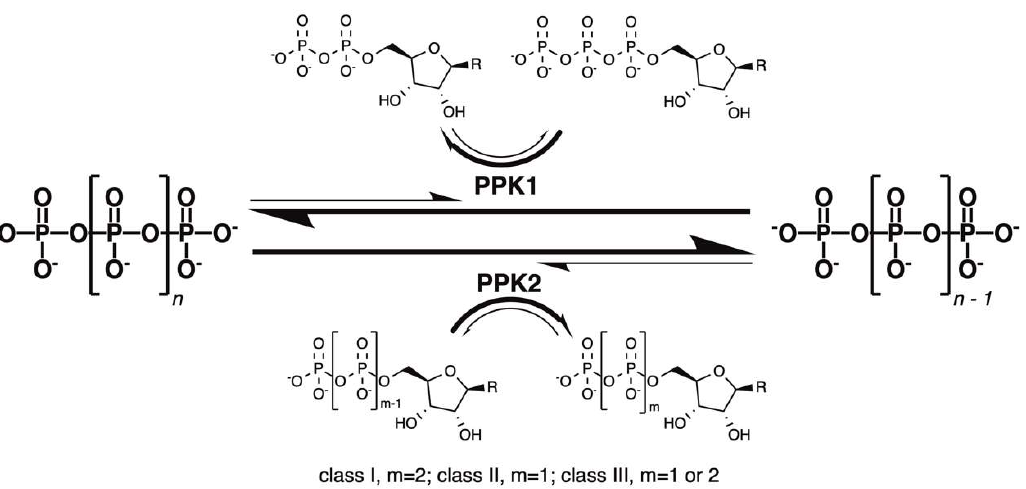
Figure 1. Comparison of the reactions catalyzed by PPK1 and PPK2 enzymes. R,